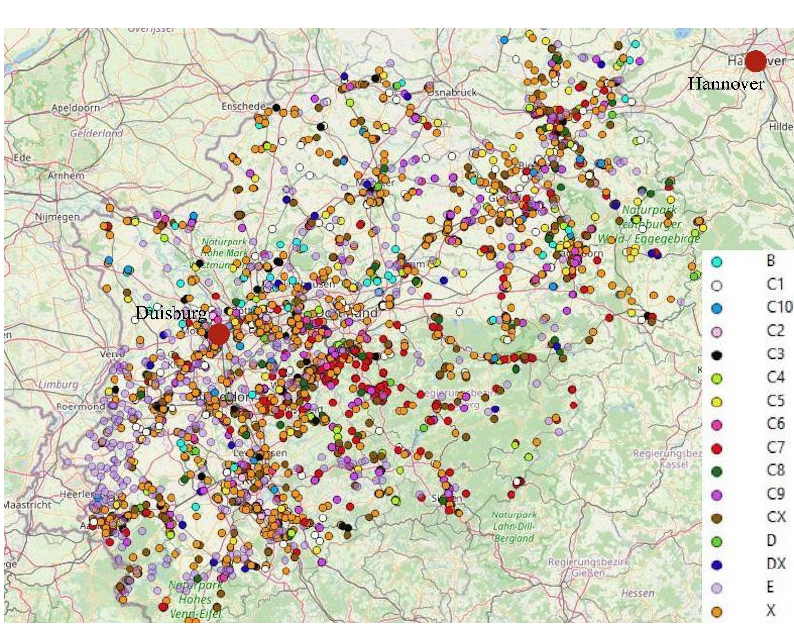
Figure 5. Company locations by industry category.